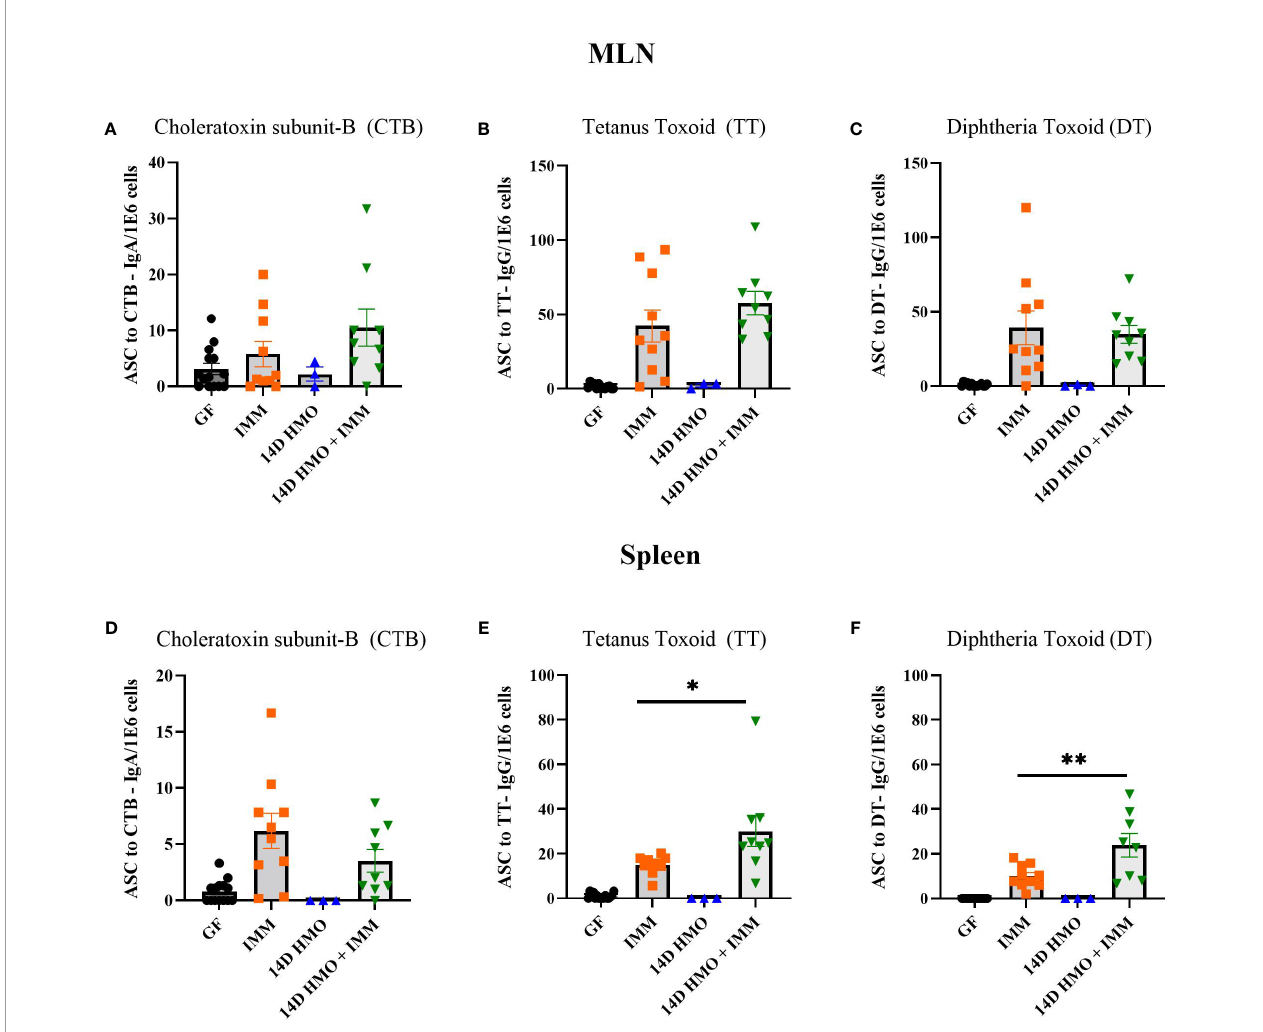
FIGURE 10 | Immunization speci fi c antibody-secreting cells (ASCs) from MLN and spleen, normalized per million cells. (A – C) CTB, TT and DT-speci fi c ASCs from MLN. (D – F) CTB, TT and DT-speci fi c ASCs from spleen. GF control (n = 16, M = 8, F = 8), immunized (IMM) (n = 10, M = 6, F = 4), 14D HMO (n = 3, F = 3) and 14D HMO + IMM (n = 9, M = 4, F = 5). Statistical signi fi cance between control and treatment groups were determined using one-way ANOVA with Bonferroni ’ s multiple comparisons correction in GraphPad Prism Version 9.3.1 and adjusted p-value <0.05 was considered signi fi cant. Outliers were removed using ROUT (Q